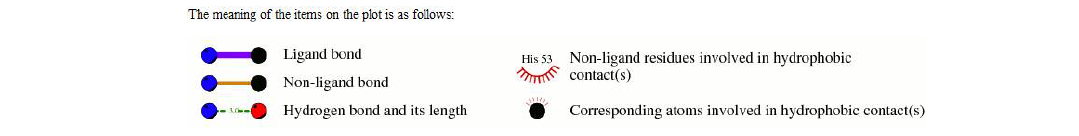
Figure 4: Protein-ligand interaction of Complex N-myristolytransferase_9,12-Octadecadienoic acid (Z,Z) Note: In N-myristolytransferase (protein) and 9,12-Octadecadienoic acid (Z,Z) (ligand) complex, the ligand form double and single hydrogen bonds (represented as green broken lines with bond length) with amino acid Leu169 and Try80 of the protein respectively.